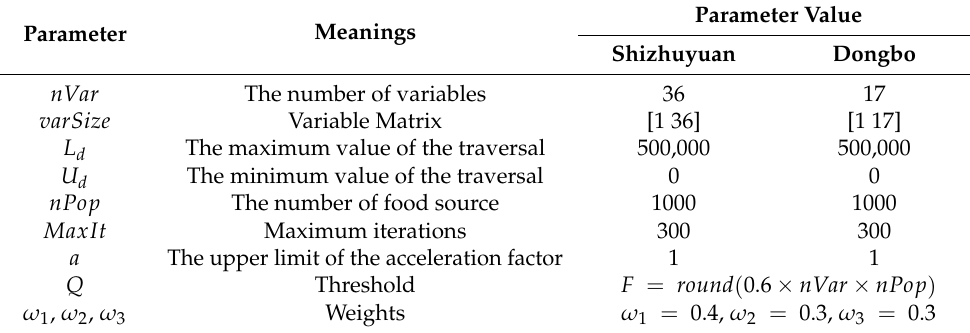
Table 4. The main parameters of the ABC